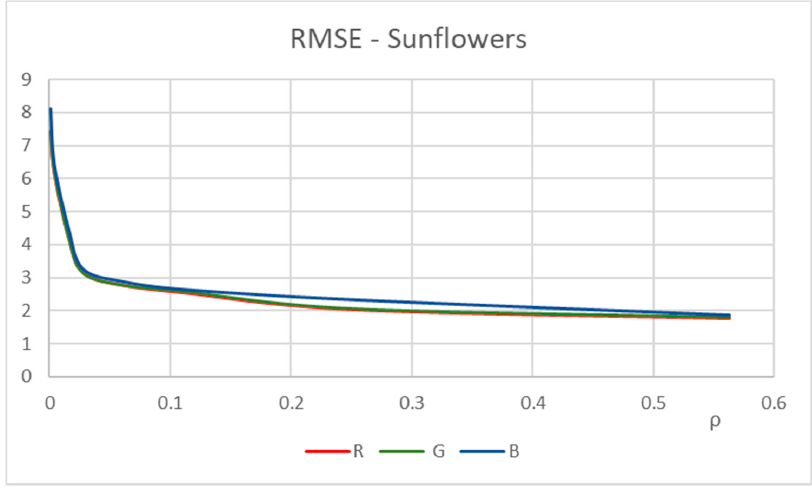
Figure 12. Sunflowers—RMSE trend in the three band.